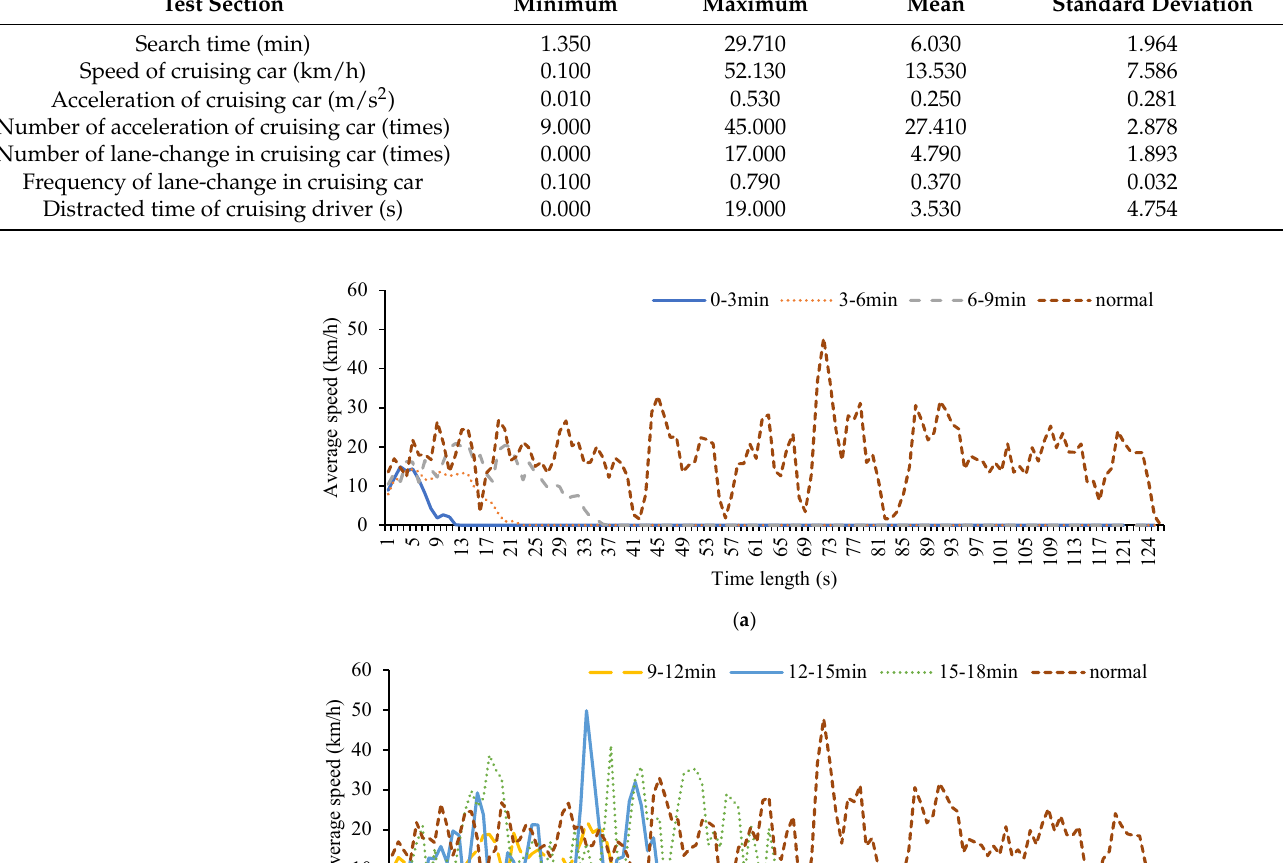
Figure 1. Investigation plan.